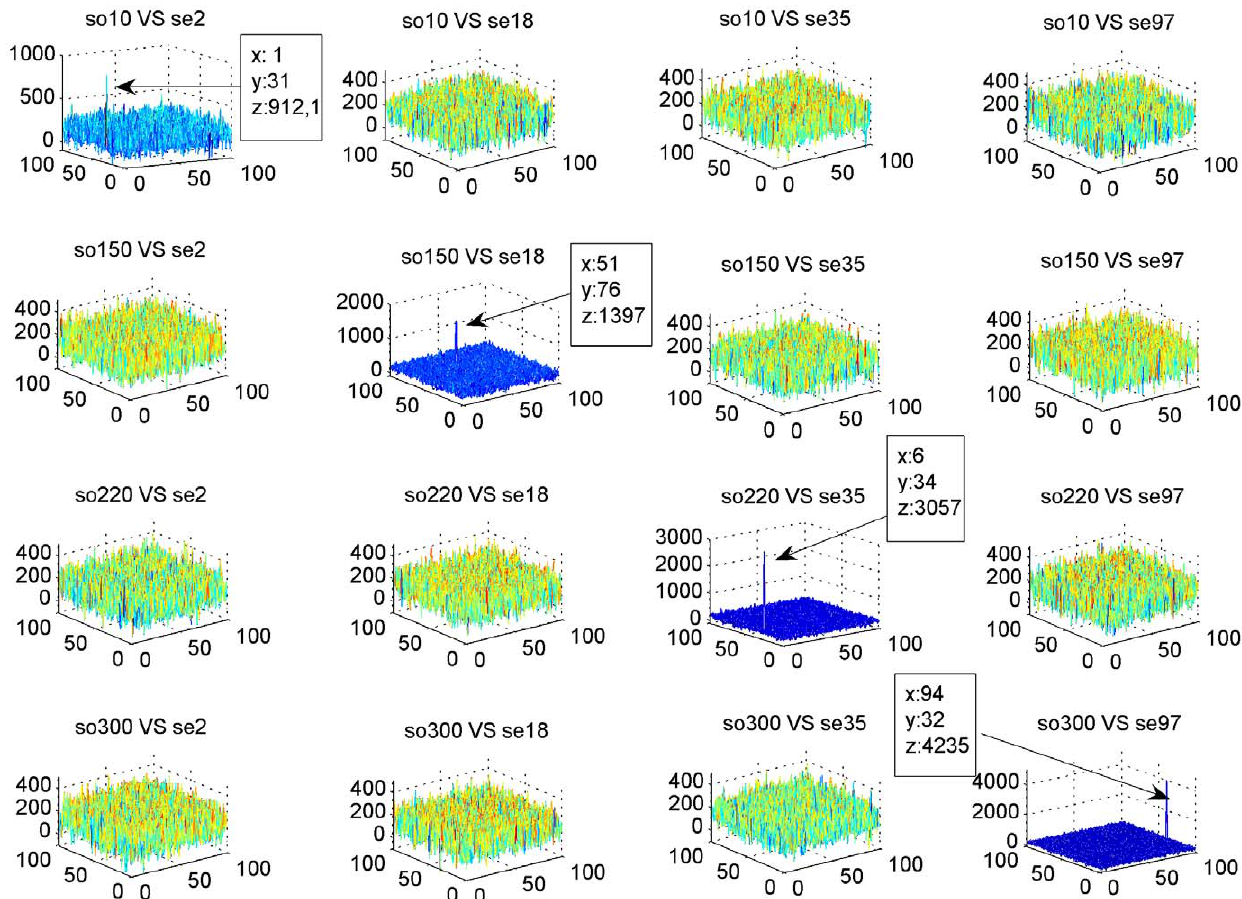
Figure 7. Results of the Correlations. The graphics presents the correlation peaks of the four objects and the four scenes presented in Figure 5. When the object sequence is correlated with the scene from where it was extracted, an outstanding peak can be observed indicating alignment (diagonal). In the other correlations, peaks are less outstanding.